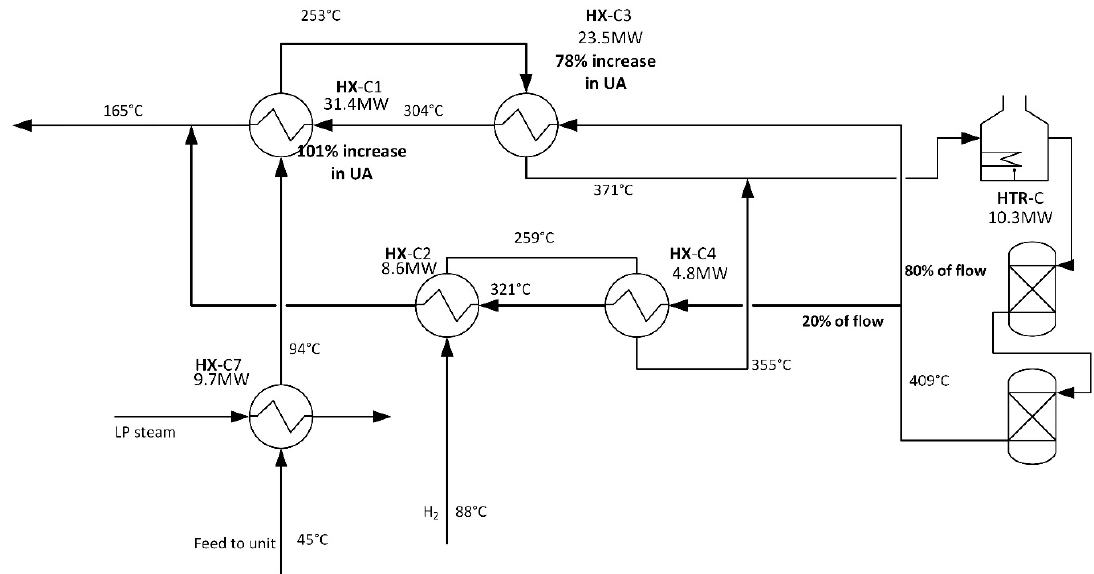
Figure A9. Retrofit proposal 4C.